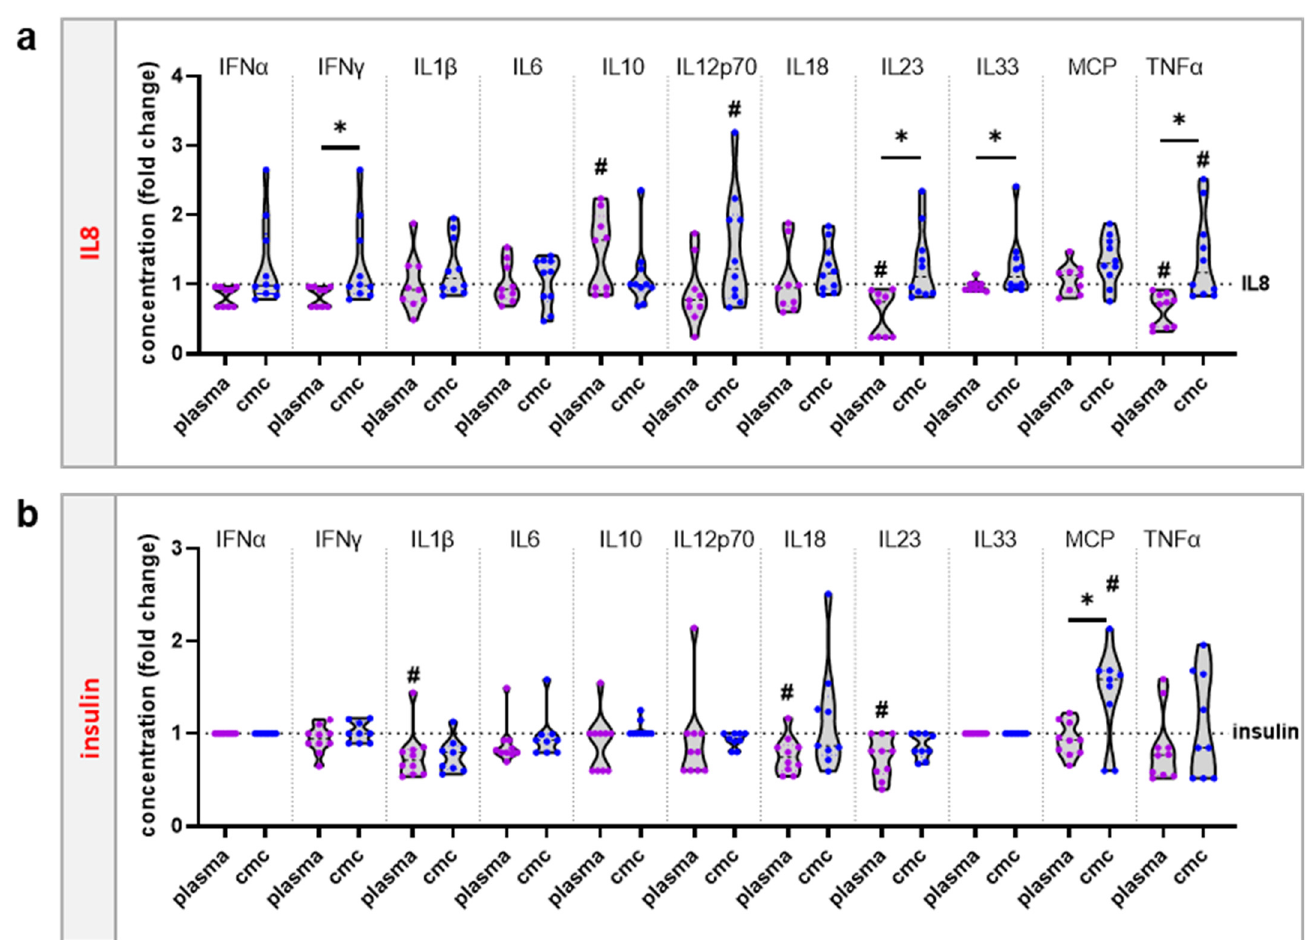
Figure 3. Oxidized IL8 and insulin led to modestly altered secretion profiles in THP-1 cells. ( a , b ) Secretion profiling was performed using bead-based multiplex assays of supernatants of THP-1 cells incubated with native or oxidized IL8 ( a ) or insulin ( b ). Data are the mean of at least three independent experiments. Statistical analysis was performed using one ‐ way analysis of variances; for ANOVA: F = 3.0 ( a )/2.6 ( b ), df = 2 ( a )/2 ( b ). * denotes statistically significant differences between plasma and cmc ( p < 0.05; t ‐ test); # denotes statistically significant differences between the individual group and the gas insulin control normalized to 1 ( p < 0.05; one ‐ way analysis of variances).